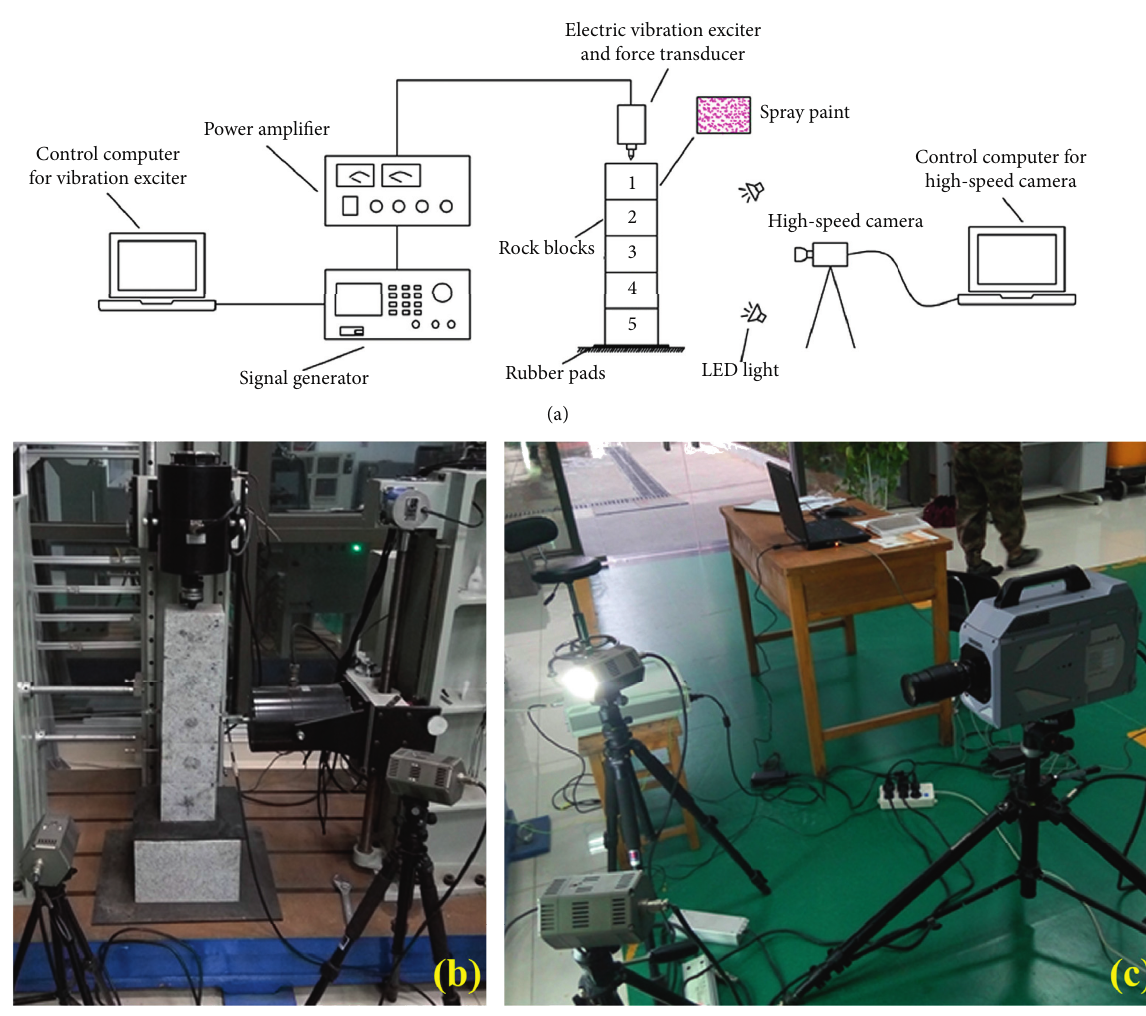
Figure 2: Experiment apparatus: (a) schematic diagram; (b) photograph of rock blocks; (c) photograph of DIC measurement system.